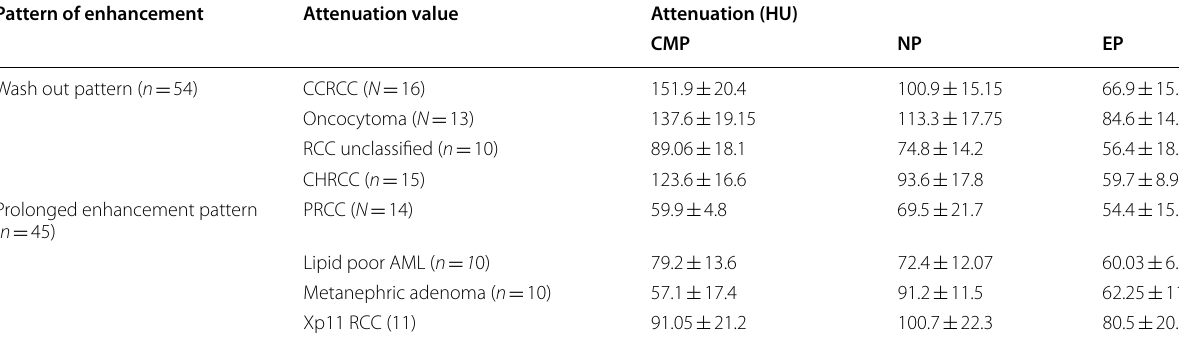
99) at various post contrast phases =